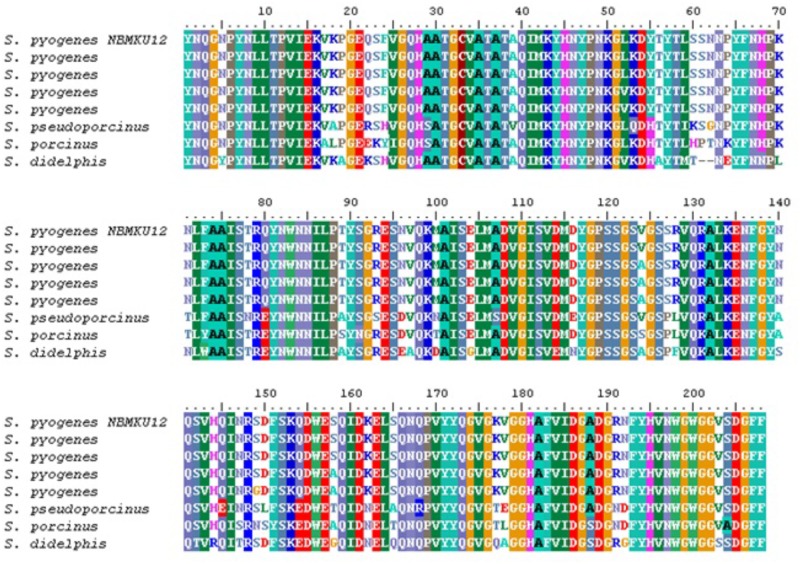
Alignment of the amino acid sequence of cysteine protease domain from Streptococcus pyogenes NBMKU12, with other cysteine proteases from Streptococcus pyogenes (WP_023079791), Streptococcus pyogenes (WP_011285235), Streptococcus pyogenes (ABX44733), Streptococcus pyogenes (WP_023610705), Streptococcus pseudoporcinus (WP_077322996), Streptococcus porcinus (WP_003083607), Streptococcus didelphis (WP_018367158). Areas shaded in dark green followed by light green indicates a high degree of similarity (>80%), and unshaded areas are regions of variability among the proteins.